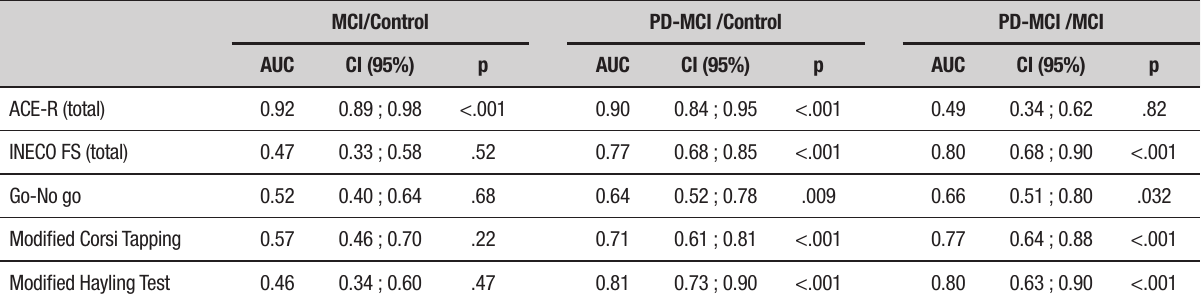
Table 2. Diagnostic accuracy of the ACE-R (total score) and INECO Frontal Screening (total scores and sub-scores) for the MCI group, PD-MCI group and between PD-MCI/MCI patients.